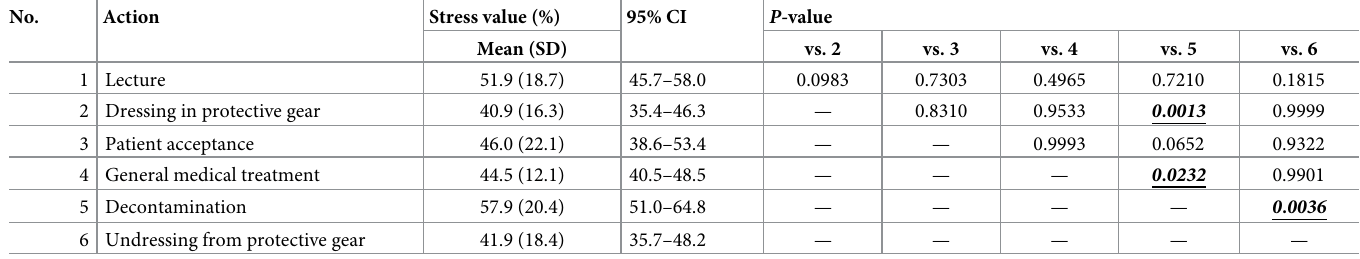
CI, confidence interval; SD, standard deviation. P -values in bold italics are statistically